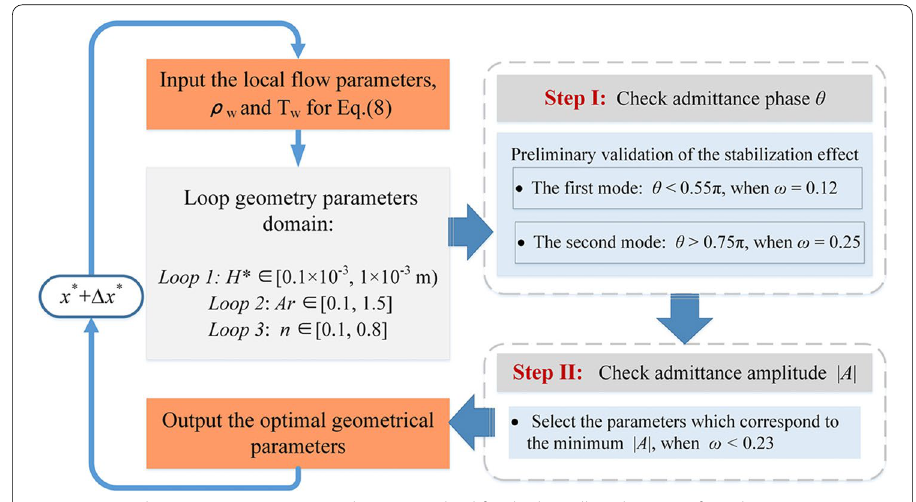
Fig. 5 Optimal geometric parameters selection method for the broadband metasurface design